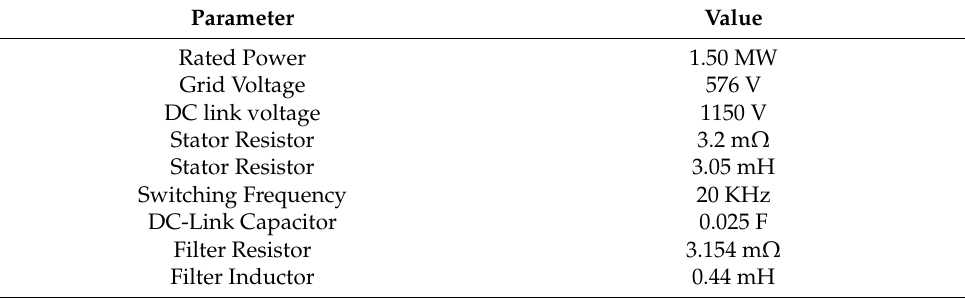
Table 4. Parameters of the GCWT